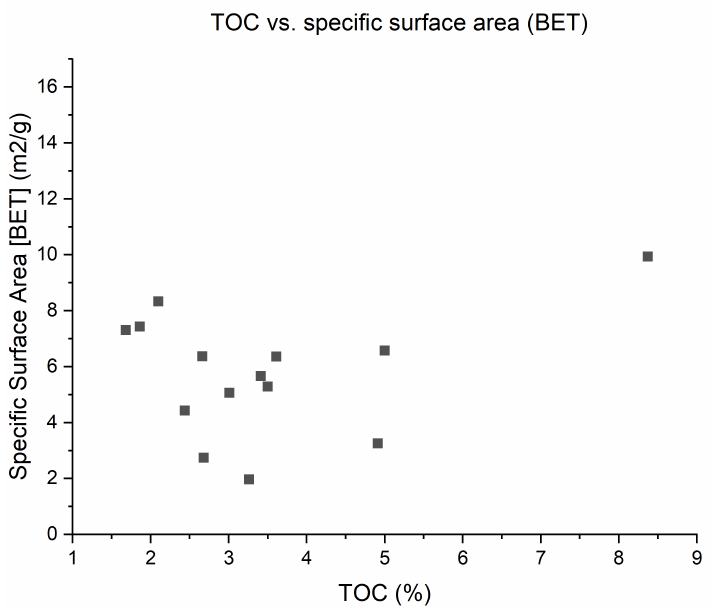
Figure 3. The relationship between TOC and SSA (values from Table 4).